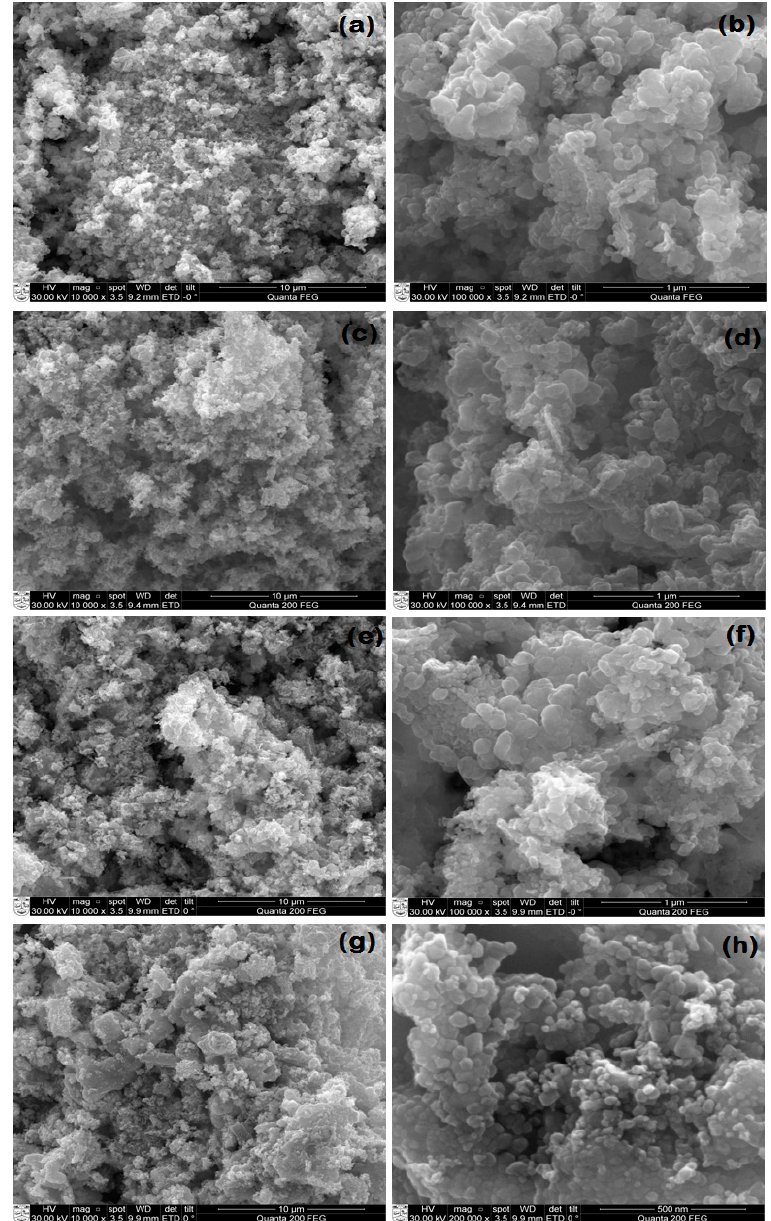
Figure 1. Low and high-magnification FESEM micrographs of pure ZnO ( a , b ) and 1% ( c , d ), 5% ( e , f ) and 10% ( g , h ) Ag-doped ZnO